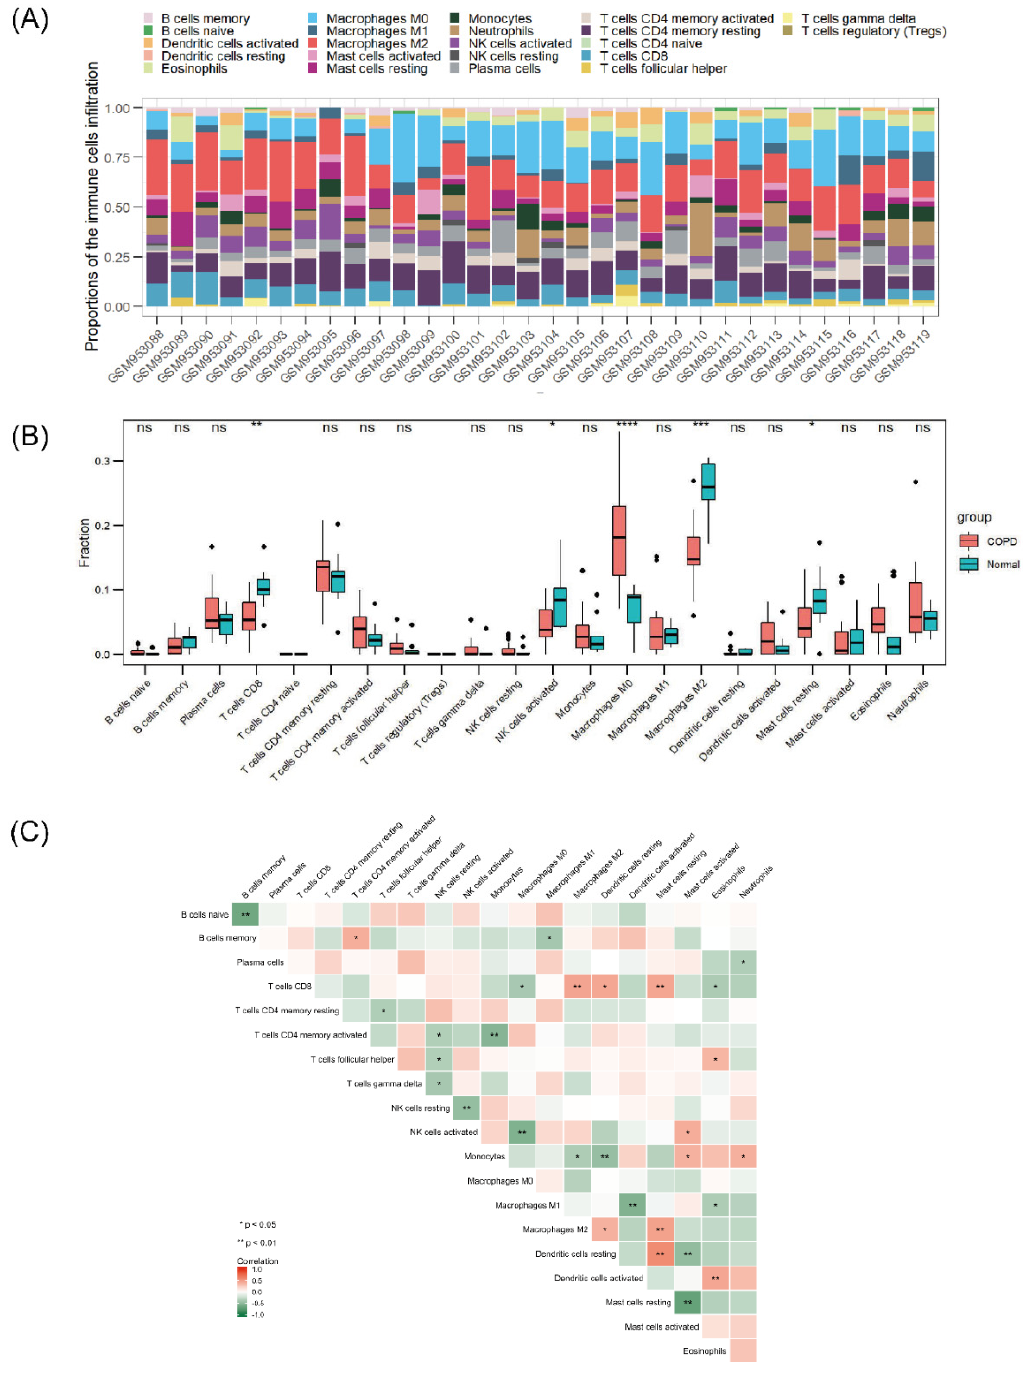
Figure 5. Landscape of immune infiltration in COPD. ( A ) Stack bar chart of immune cells. ( B ) Box plot of the immune cell proportions. ( C ) Heatmap of the correlation matrix of immune cells. ns p > 0.05, * p < 0.05, ** p < 0.01, *** p < 0.001, **** p < 0.0001.